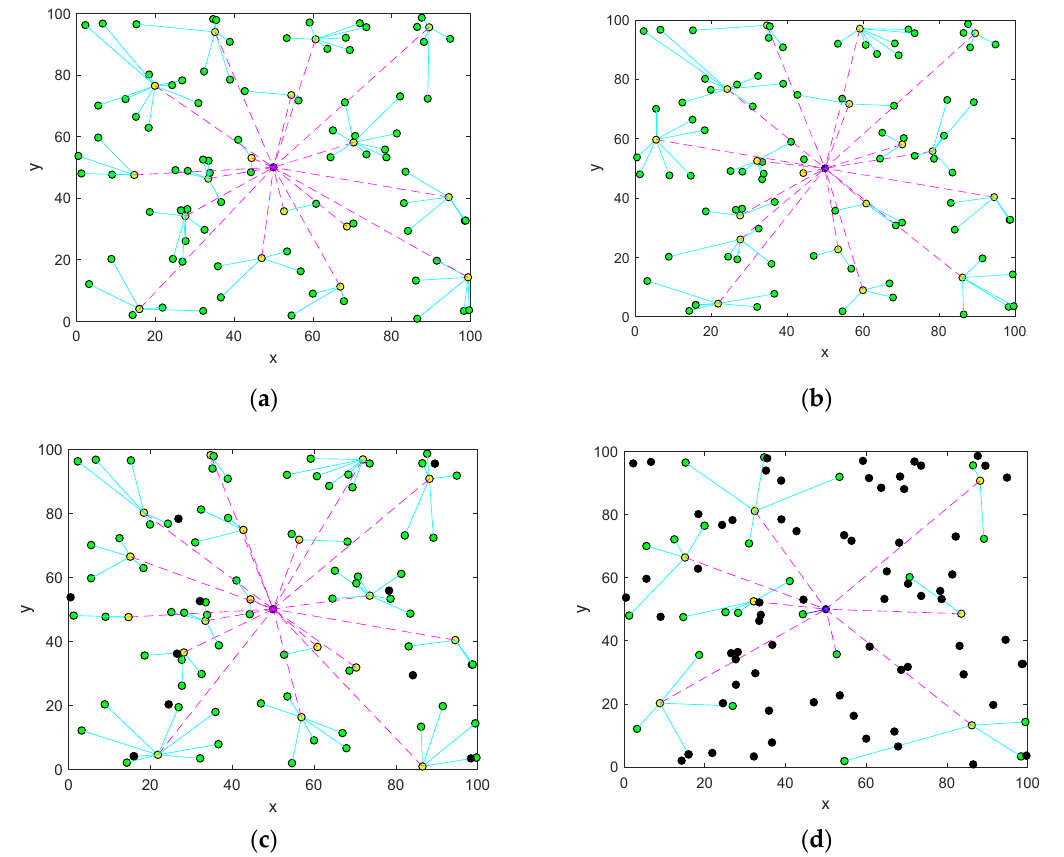
Figure 3. Clustering evolution of the network: ( a ) network configuration in round 5, ( b ) in round 100, ( c ) in round 270, and ( d ) in round 400.